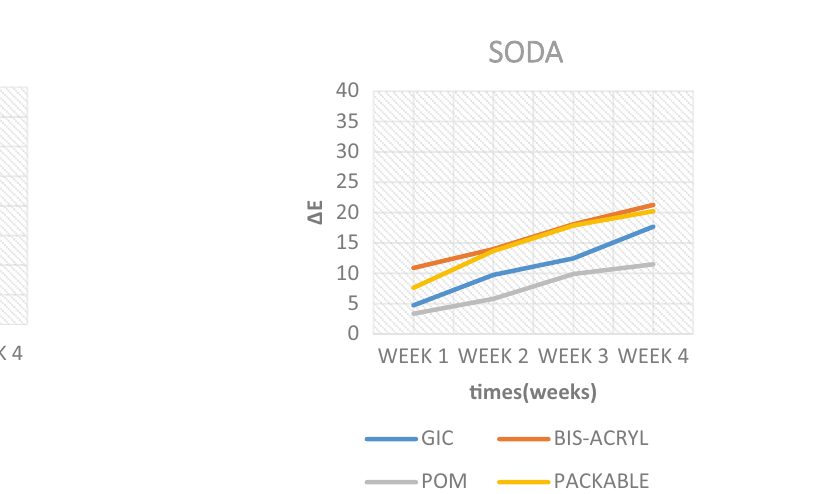
Fig. 10 Colour change over time of test materials in soda.